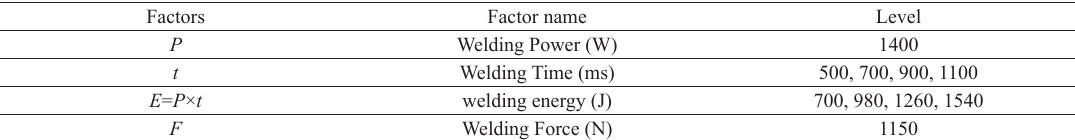
Table 2. The ultrasonic welding process